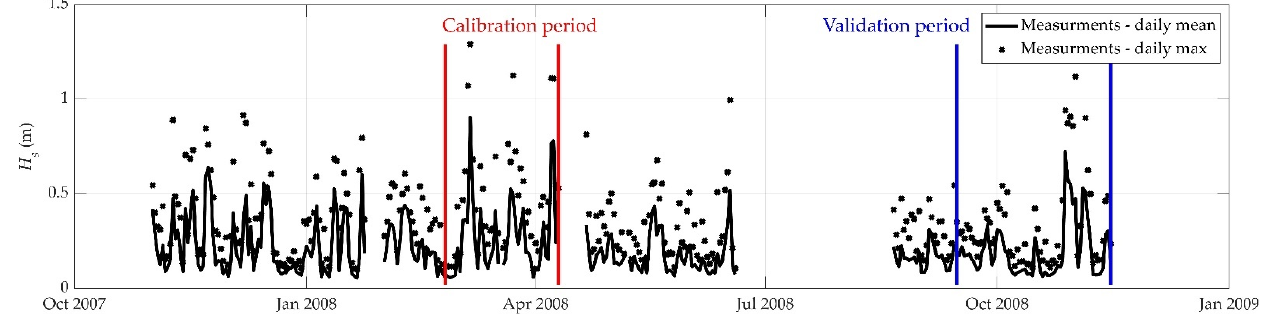
Figure 2. Time series of measured significant wave heights at wave buoy location in front of Split (location shown in Figure 1 with a red dot) with indicated calibration period (in red) and validation period (in blue).